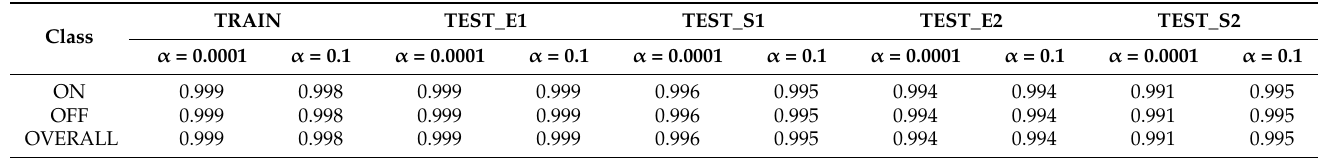
Table 3. Classification accuracy of the selected